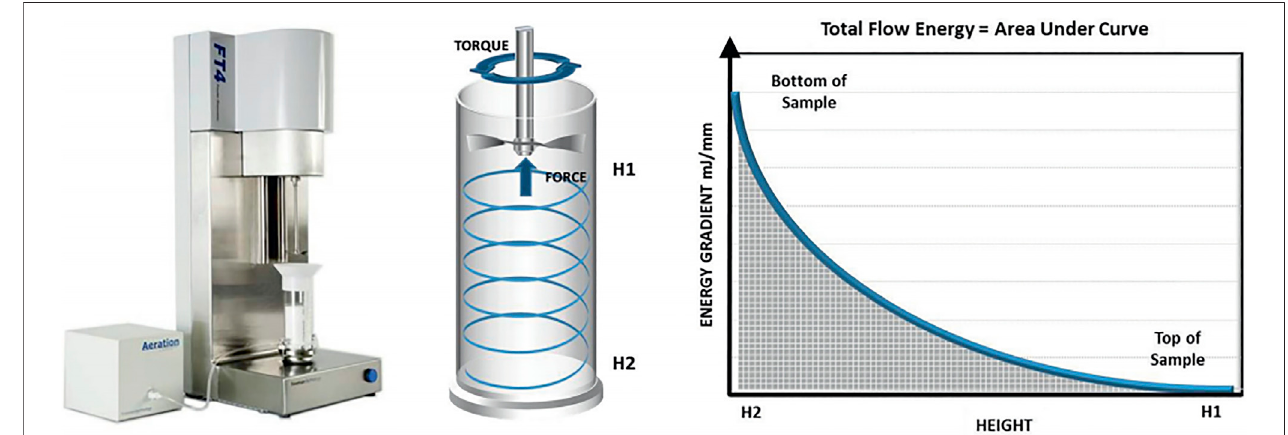
FIGURE3| Stabilityandvariable fl owratetestsetup.Thegraphontherightdepictsthecalculationofthetotalenergyofatestcycle.Adaptedwithpermissionfrom Freeman et al. (2015).